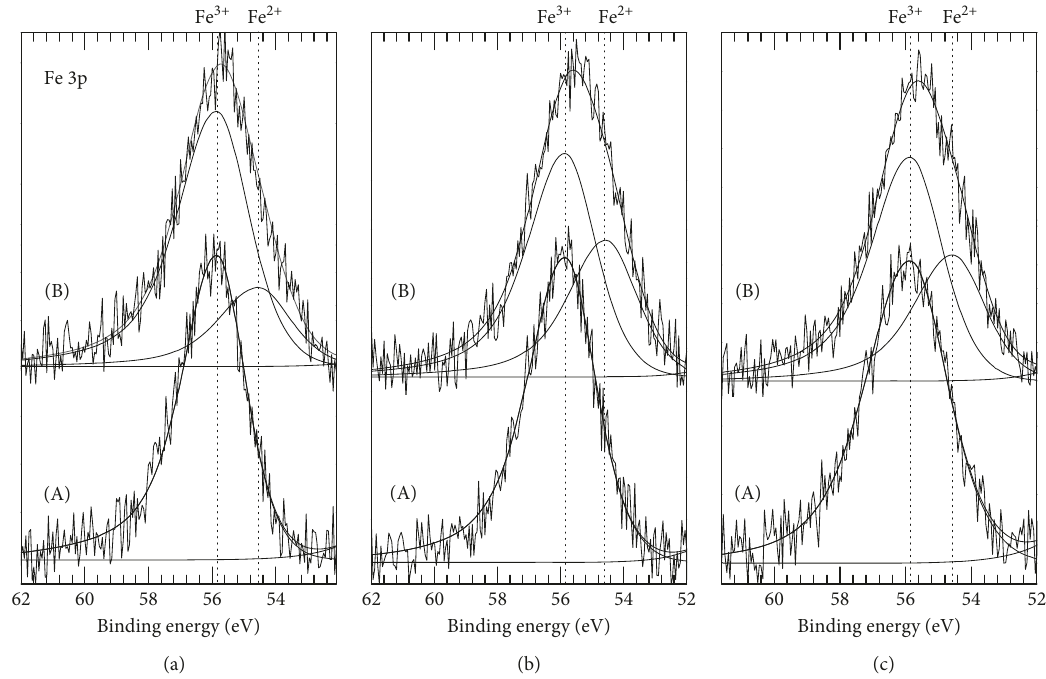
Figure 6: XPS photoelectron spectra of Fe 3p for Mn-Zn ferrite: (a) P1-C2O4, (b) P2-CO3, and (c) P3-OH in (A) “as-received” form and (B) after Ar + sputtering (90s, 2keV, 4.1 µ A/cm 2 ).